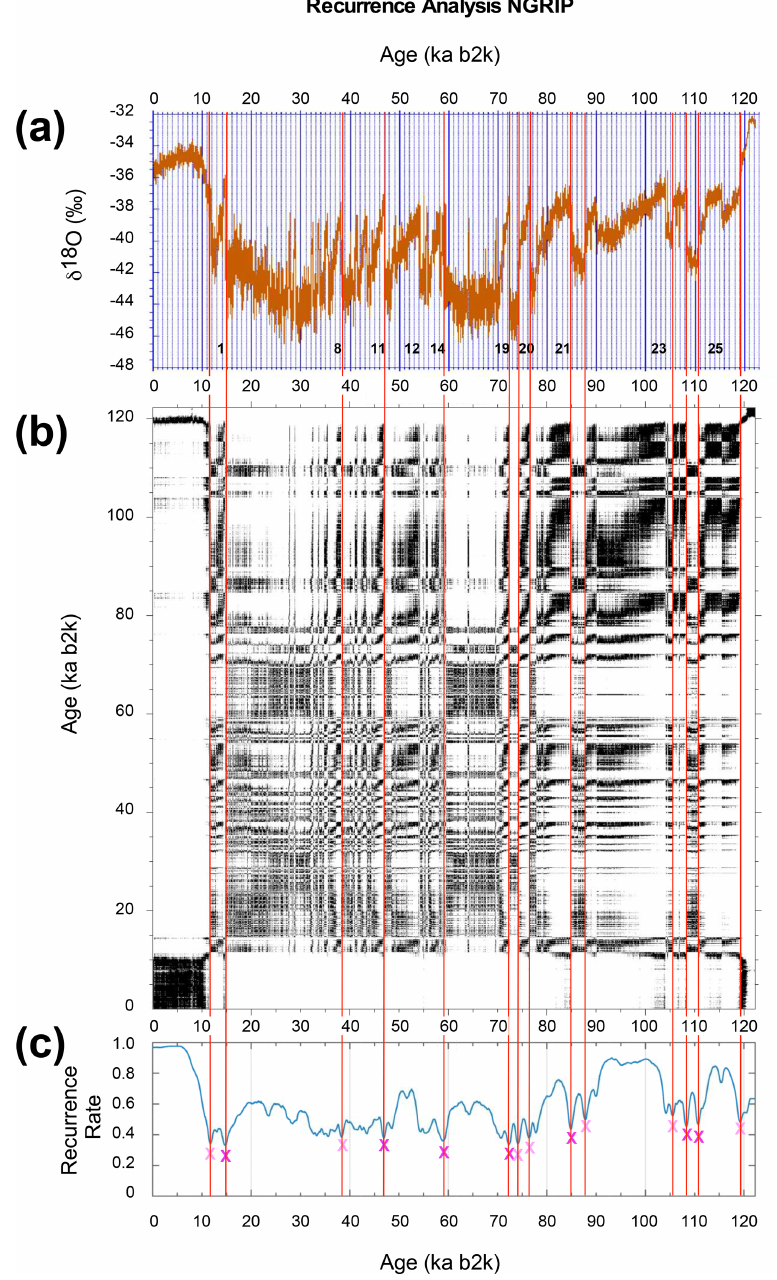
Figure 4. Recurrence analysis of NGRIP δ 18 O. (a) NGRIP δ 18 O variations over the last 122kyrb2k (Rasmussen et al., 2014); selected canonical Dansgaard-Oeschger (DO) events are indicated on the abscissa by the numbers assigned by Dansgaard et al. (1993). (b) RP of the time series in panel (a) above; the proximity threshold here is (cid:49) ( δ 18 O) = 1 . 3‰. (c) Recurrence rate analysis showing the selected thresholds (7 + 7) indicated by the vertical bars. The RP web site is